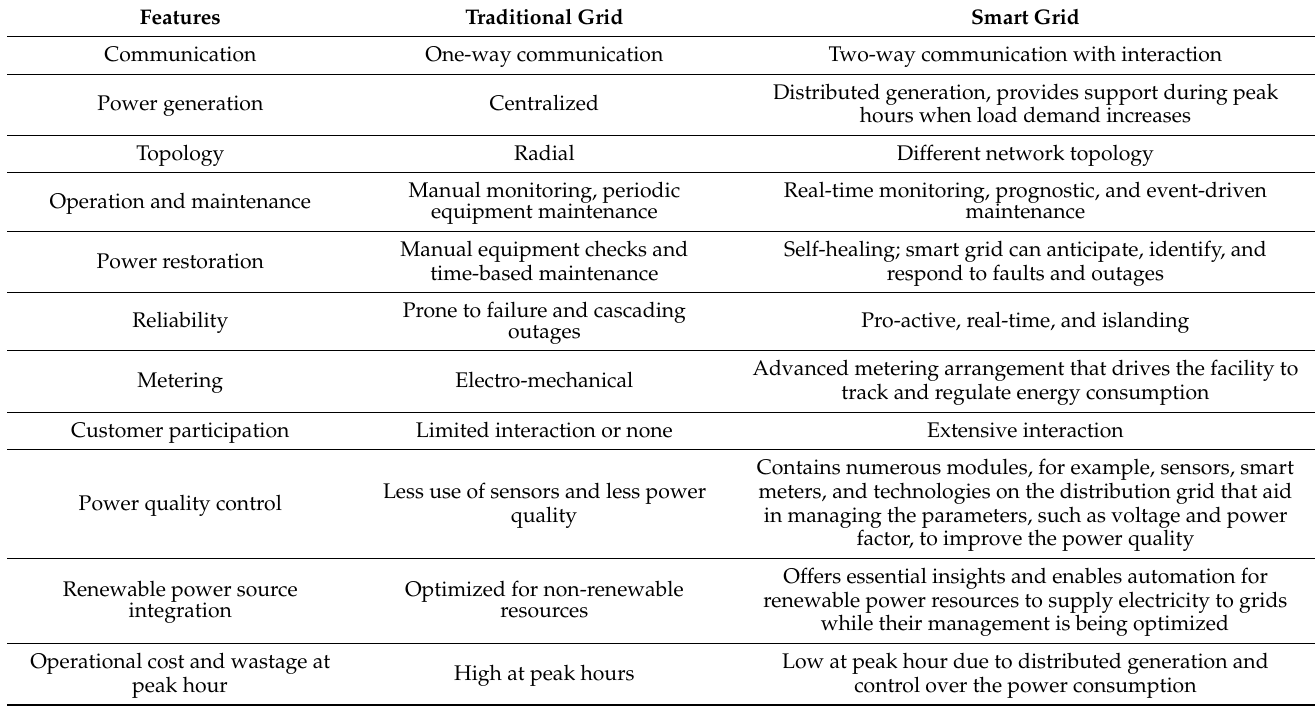
Table 1. Advantages of smart grids over traditional